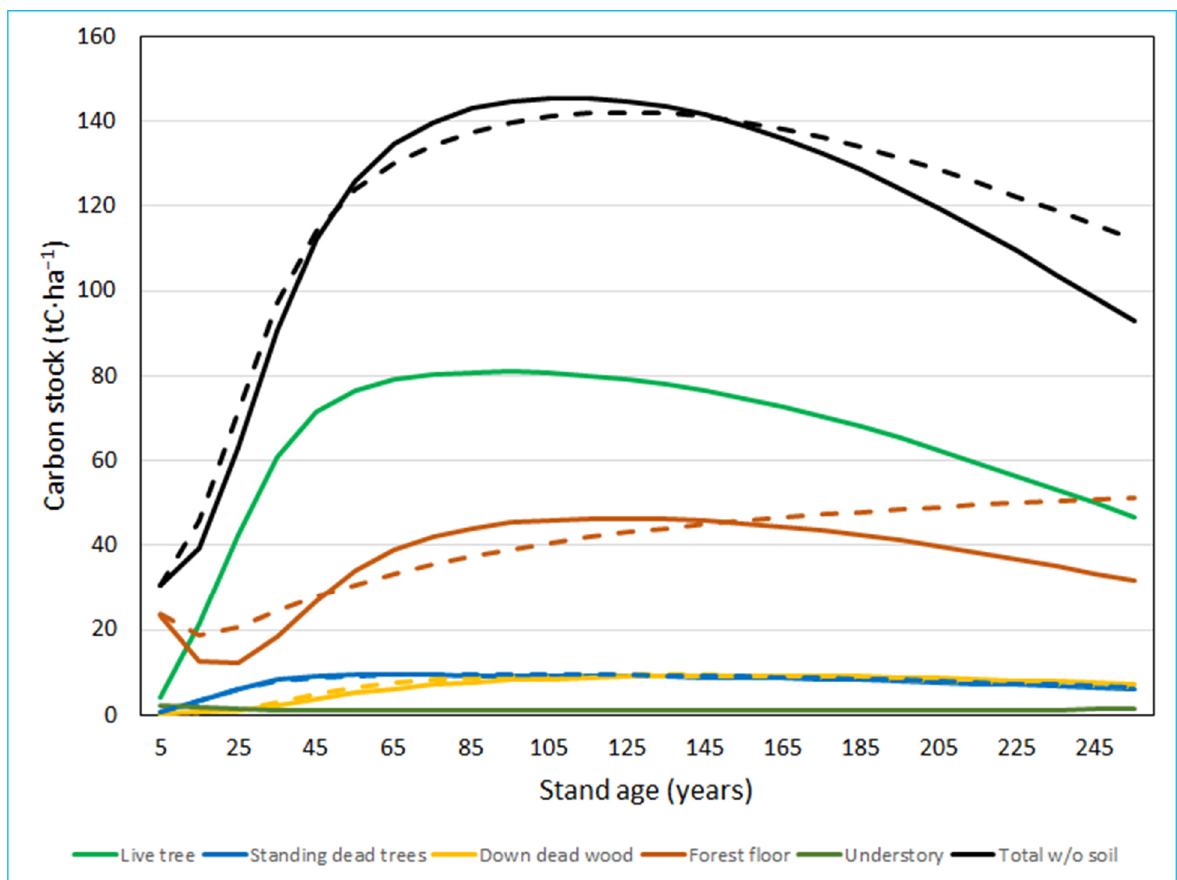
Figure 2. Carbon stocks in individual pools and the total forest ecosystem (soil omitted) for a jack pine-dominated stand in northwestern Ontario. Solid and dashed lines correspond to estimates produced by equations developed in this study and those in FORCARB-ON2, respectively.